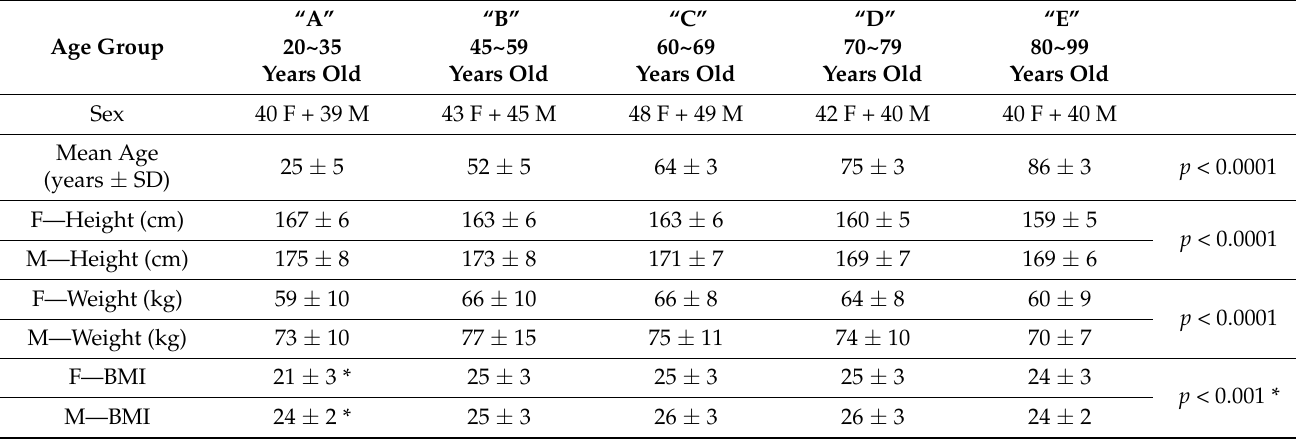
Table 1. Anthropometric measures stratified by sex and age.